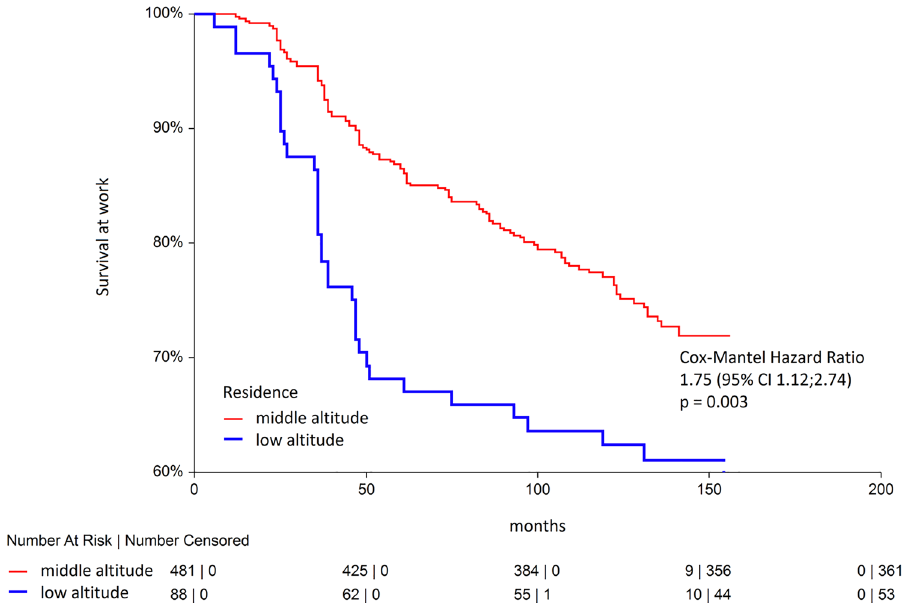
Figure 2. Kaplan–Meier curves for lowland and middle-altitude residents in a prospective